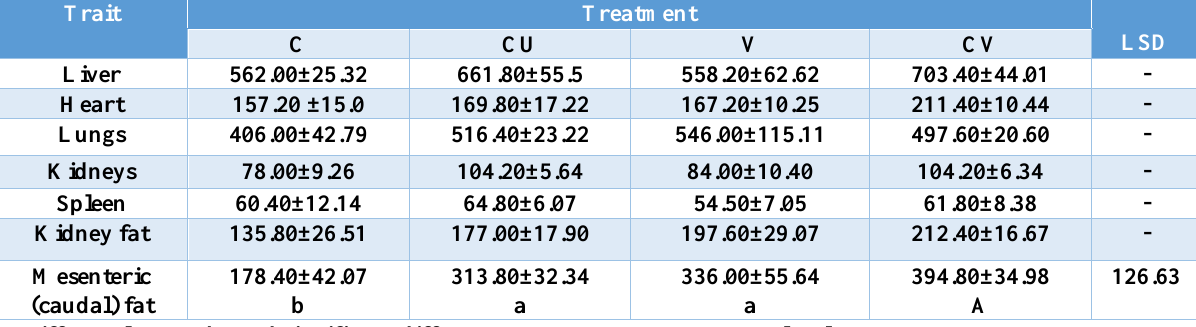
Different letters showed significant difference among treatments at 5% level.